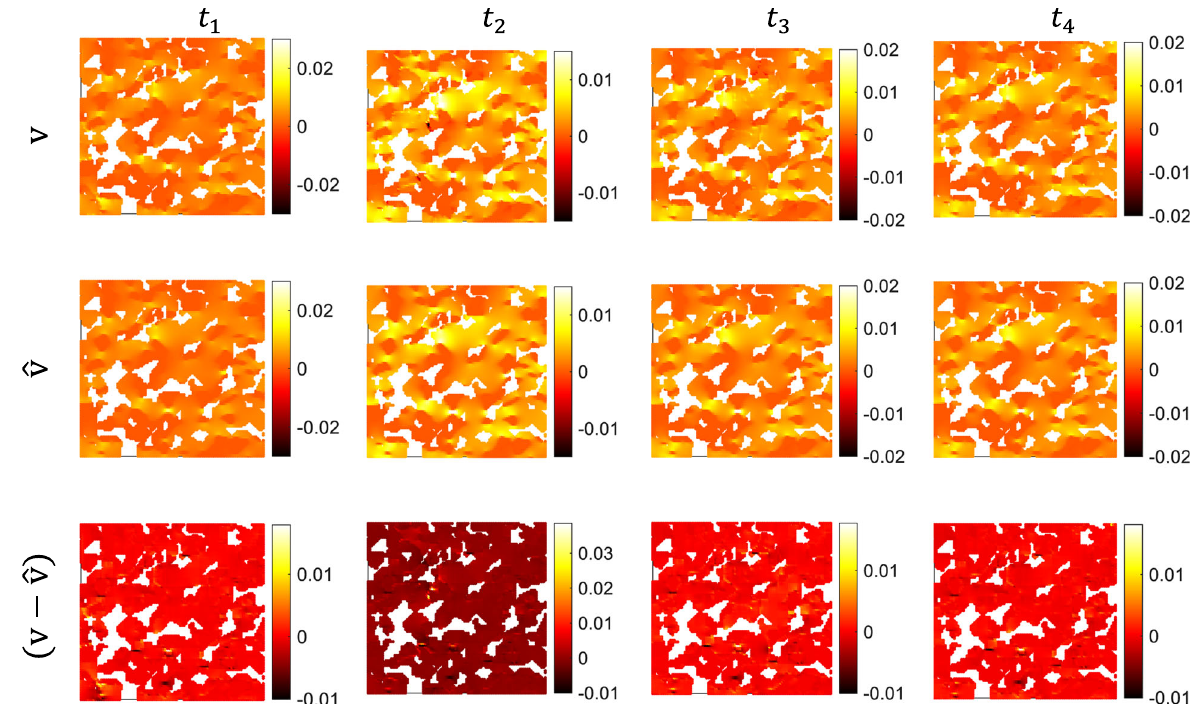
Fig. 4 Prediction of the fl uid velocity fi eld by the trained PIRED. Comparison of the predicted fl uid velocity j ^ v j with the numerically calculated values at four (dimensionless) times.